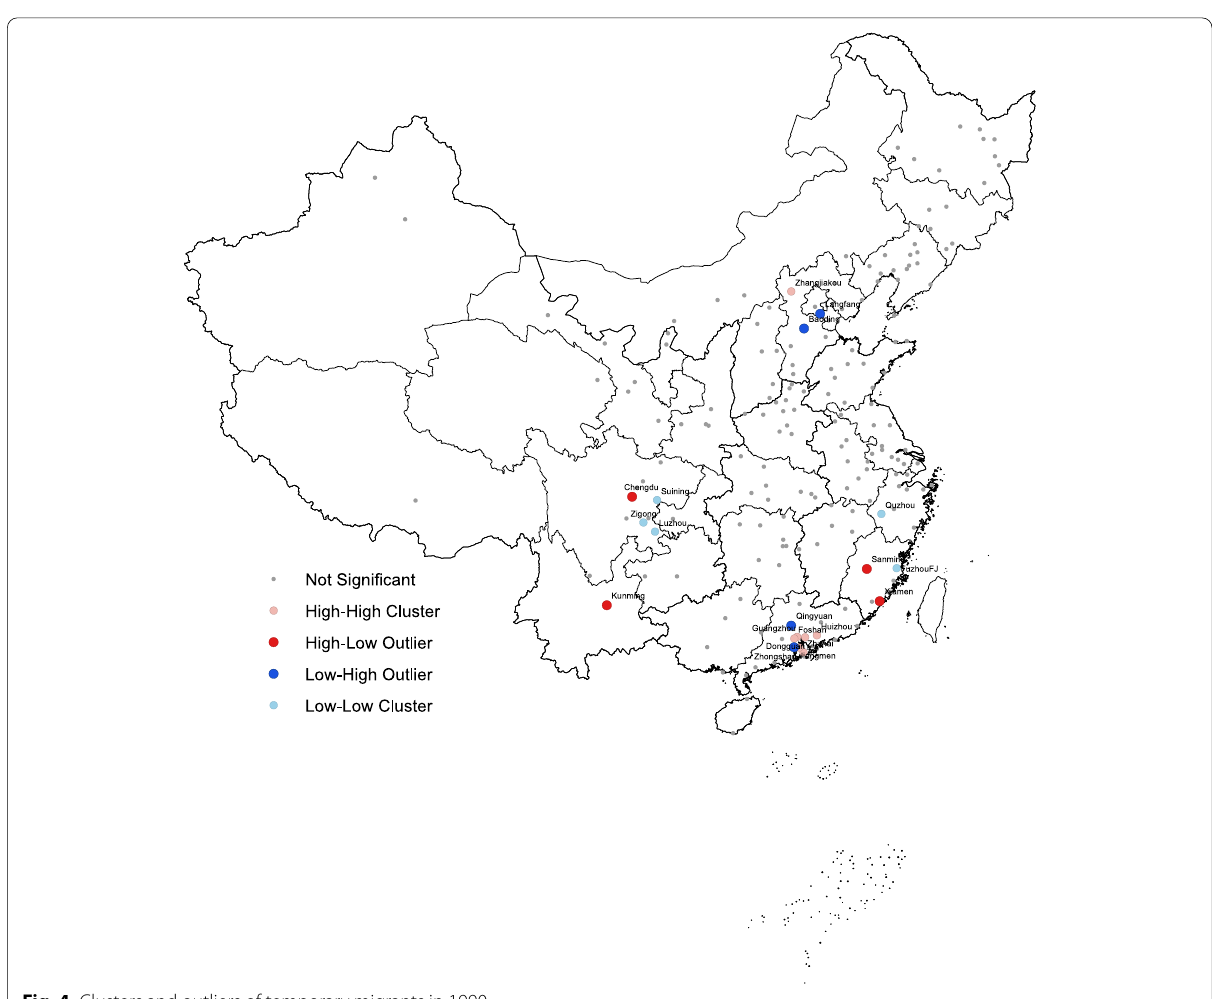
Fig. 4 Clusters and outliers of temporary migrants in